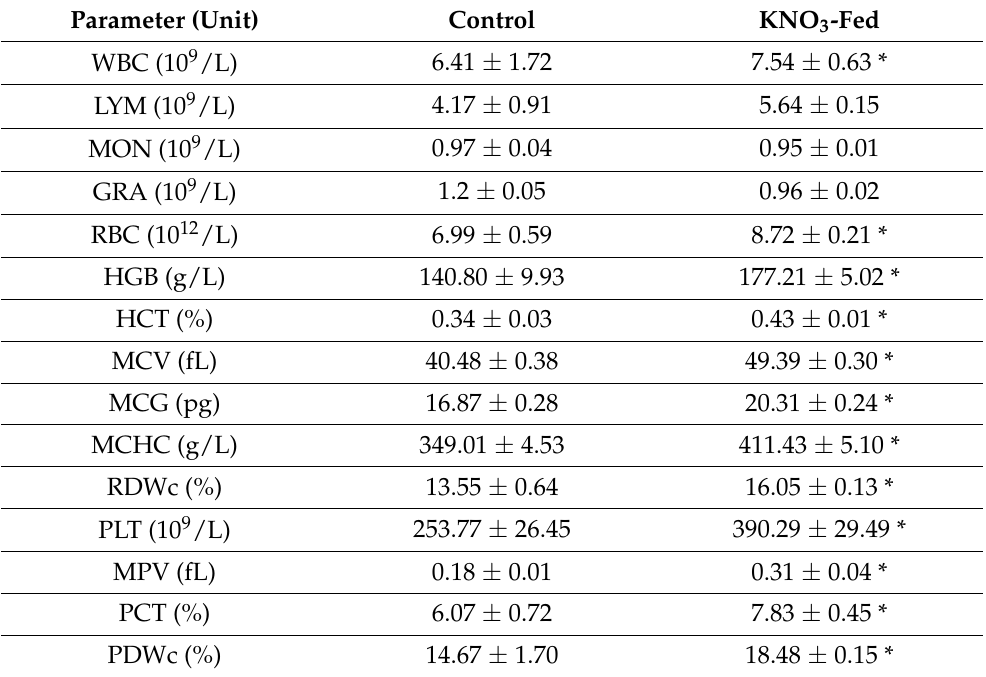
Table 2. Effects of KNO 3 on blood chemical parameters in a diet.